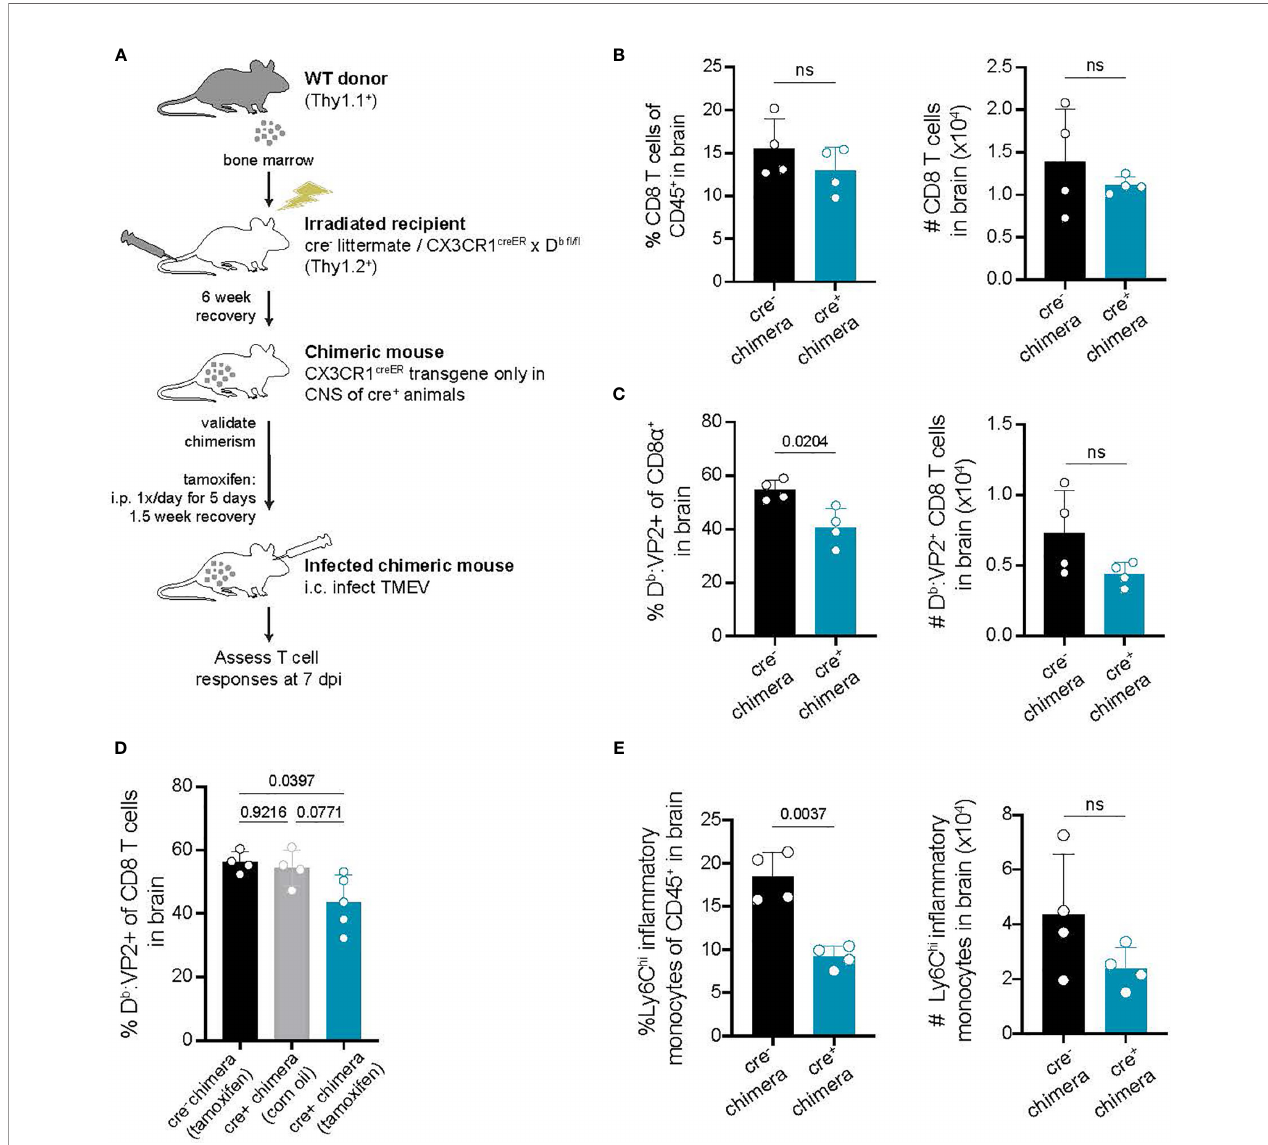
FIGURE 6 | Deletion of H-2D b in only CNS-myeloid cells reduces immune in fi ltration following TMEV infection. (A) Bone marrow chimeras were generated by lethal irradiation of recipient cre- littermates and CX3CR1 cre /D b mice followed by reconstitution with WT congenic (Thy1.1) bone marrow. Six weeks later, after validation of chimerism, chimeric mice received intraperitoneal tamoxifen treatment. After recovery, chimeric mice were intracranially infected with TMEV to assess antiviral responses. (B – C) The frequency and number of CD8 T cells (B) and VP2-speci fi c CD8 T cells (C) recovered from the brains of cre - and CX3CR1 cre /D b mice. (D) A new set of chimeras were generated with the addition of a CX3CR1 cre /D b group treated with vehicle control. The frequency of D b : VP2 + CD8 T cells recovered from the brains of these chimeras was quanti fi ed. (E) Quanti fi cation of Ly6C hi in fi ltrating in fl ammatory monocytes recovered from the brains of chimeric cre - and CX3CR1 cre /D b mice. Data are shown as individual mice with mean from one independent experiment (n=3-6) of ≥ 3 experimental replicates. Error bars represent standard deviation. Two tailed Welch ’ s t test or one-way ANOVA with Tukey ’ s correction were used to assess statistical signi fi cance with ns p ≥